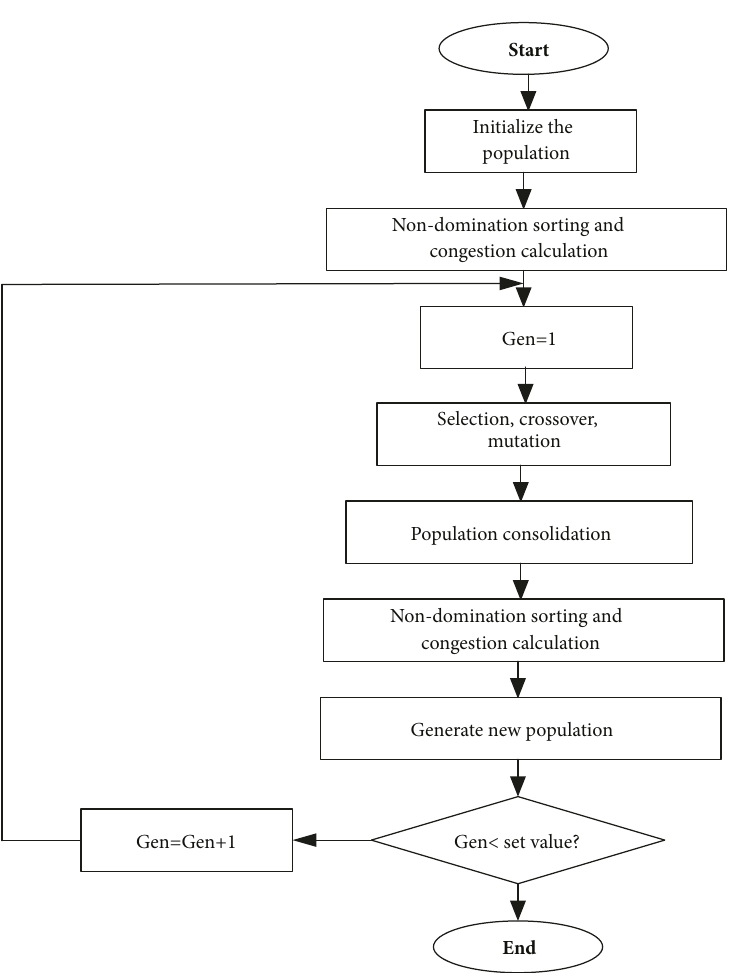
Figure 3: The framework of the NSGA-II